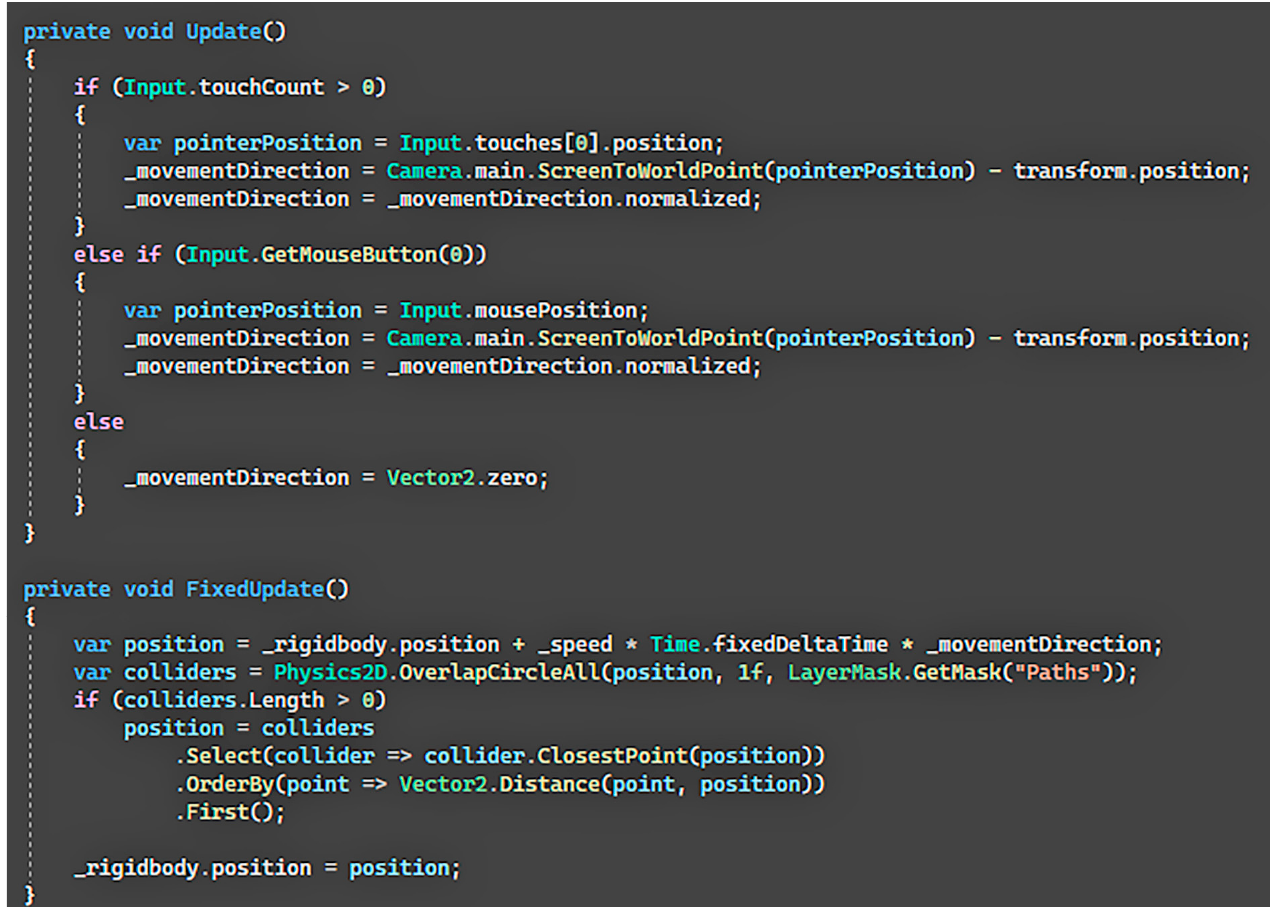
Figure 3. The implementation of moving toward the touch by the user’s finger.